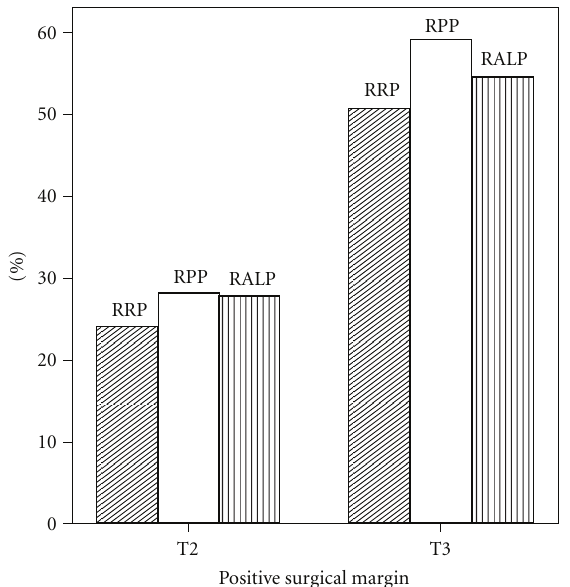
Figure 2: Positive surgical margin rate in pT2-3 diseases ( n = 2270 between 1993 and 2008, data from Duke Prostate